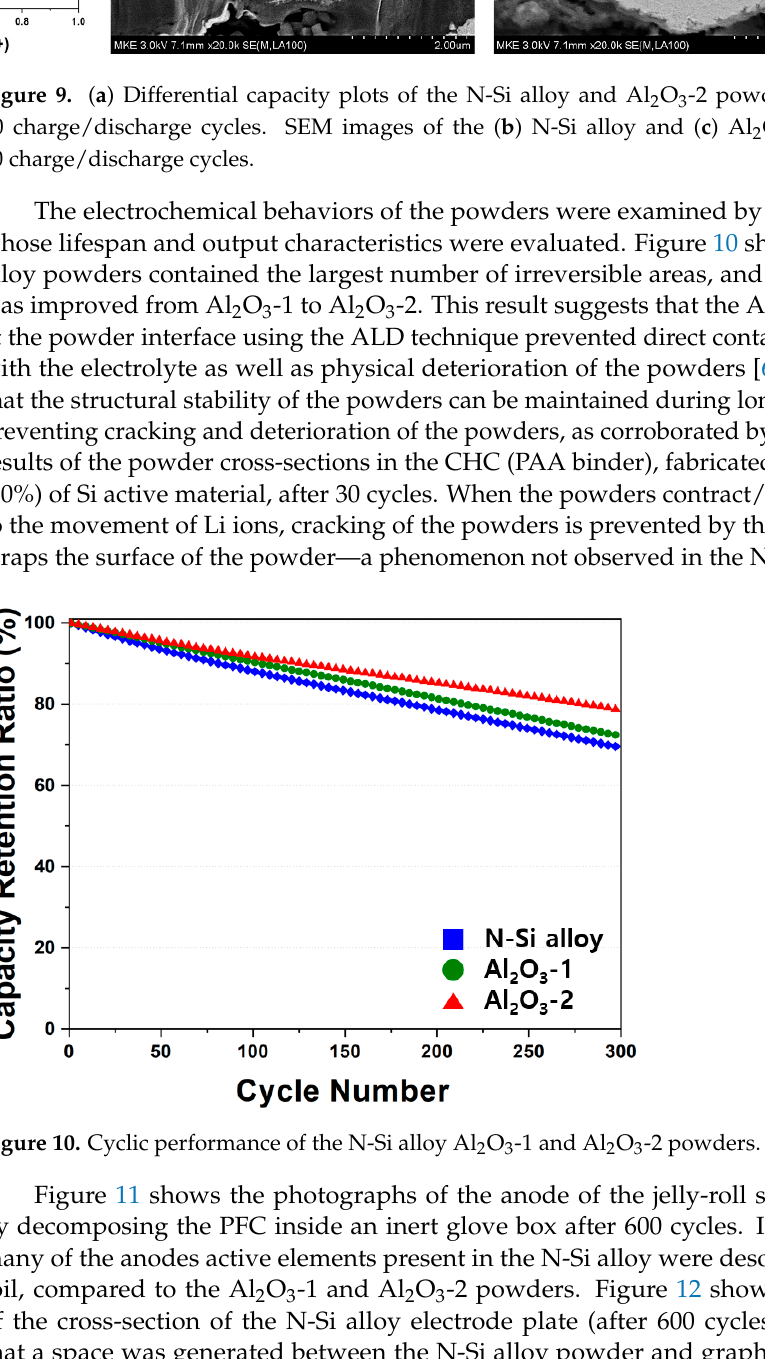
Figure 10. Cyclic performance of the N-Si alloy Al 2 O 3 -1 and Al 2 O 3 -2 powders.